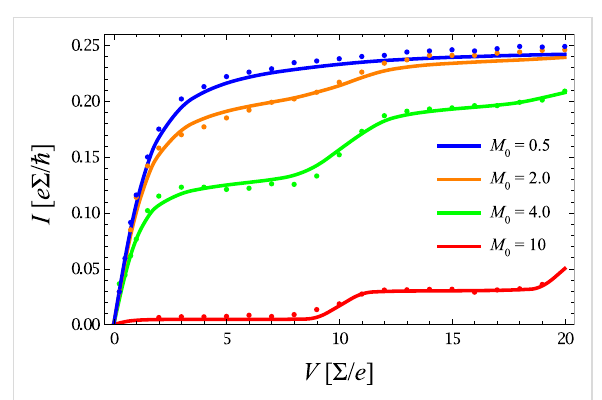
Figure 10: As Figure 7, but for nonequilibrated phonons based on an extended master equation (solid) in comparison to exact diagMC data